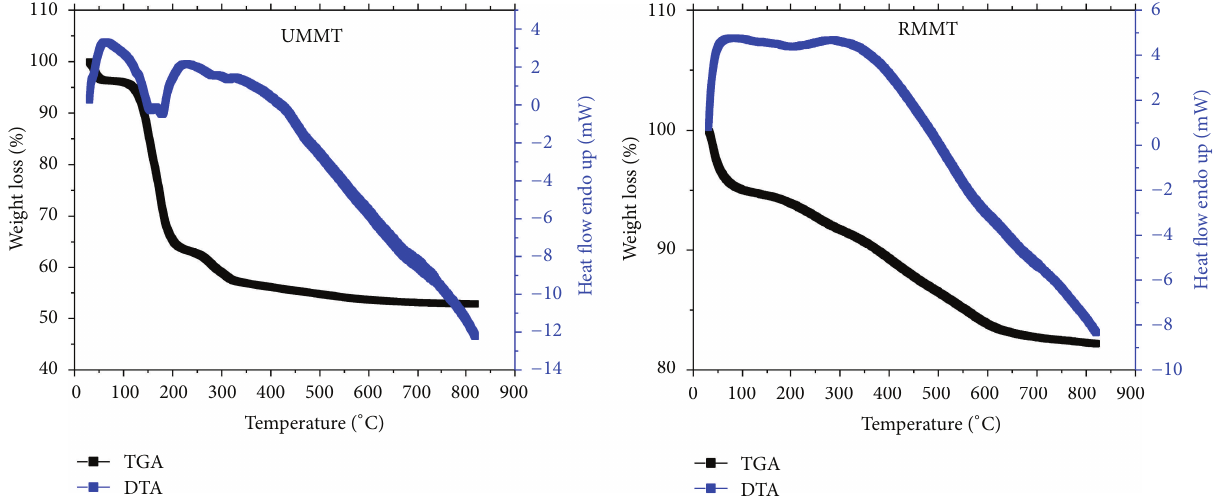
Figure 9: TGA/DTA curves of UMMT and RMMT.